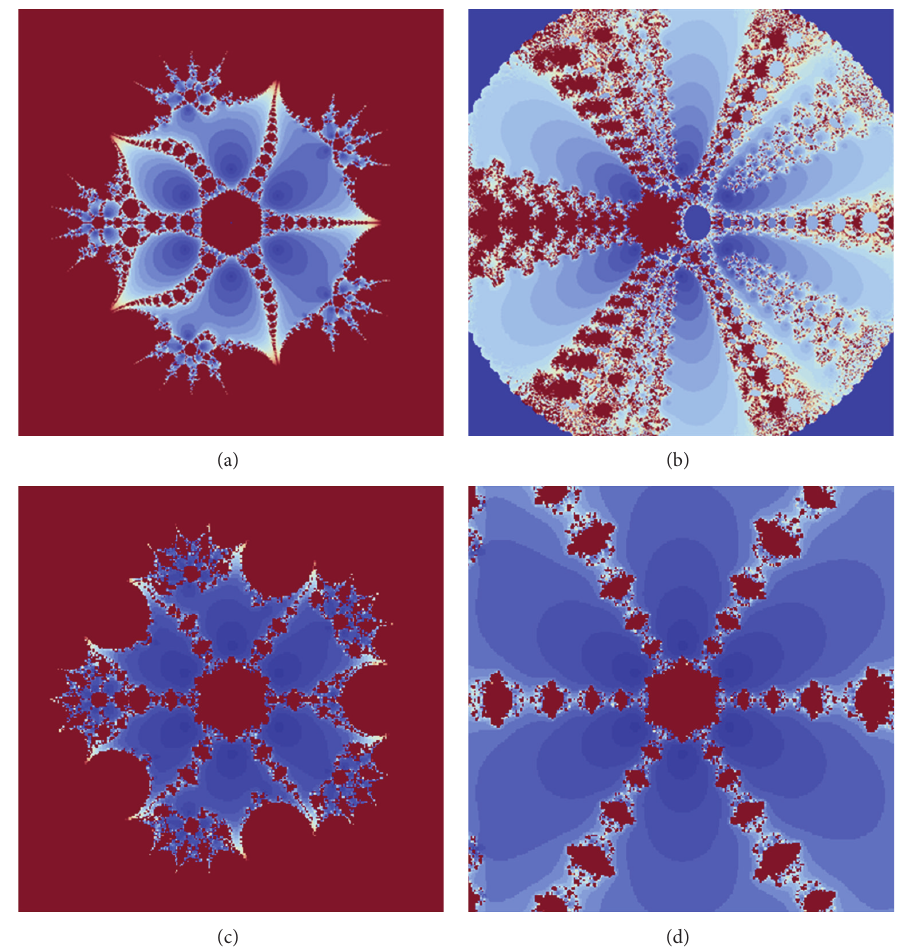
Figure 6: Fractal behavior for the rational function associated to the Steffensen’s method with 𝛽 = 0.01 (a), Jain’s method (b), (3) with 𝛽 = 0.01 (c) and (3) with 𝛽 = 0.0001 (d) for 𝑓 : 𝑧 → 𝑧 6 + 1 . Shading according to the number of